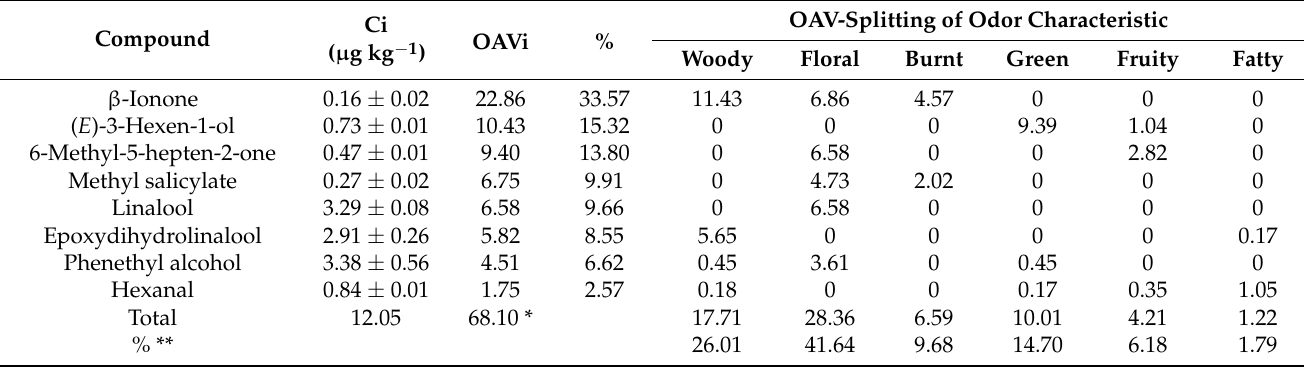
Table 1. The content, OAVi and OAV-splitting of key aroma compounds in white